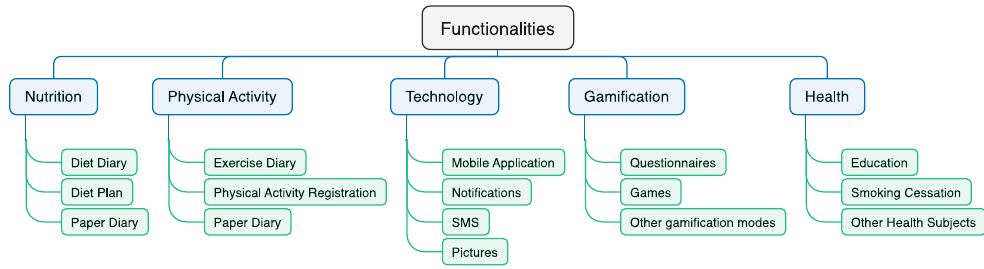
Figure 2. Taxonomy of the features included in the different studies.